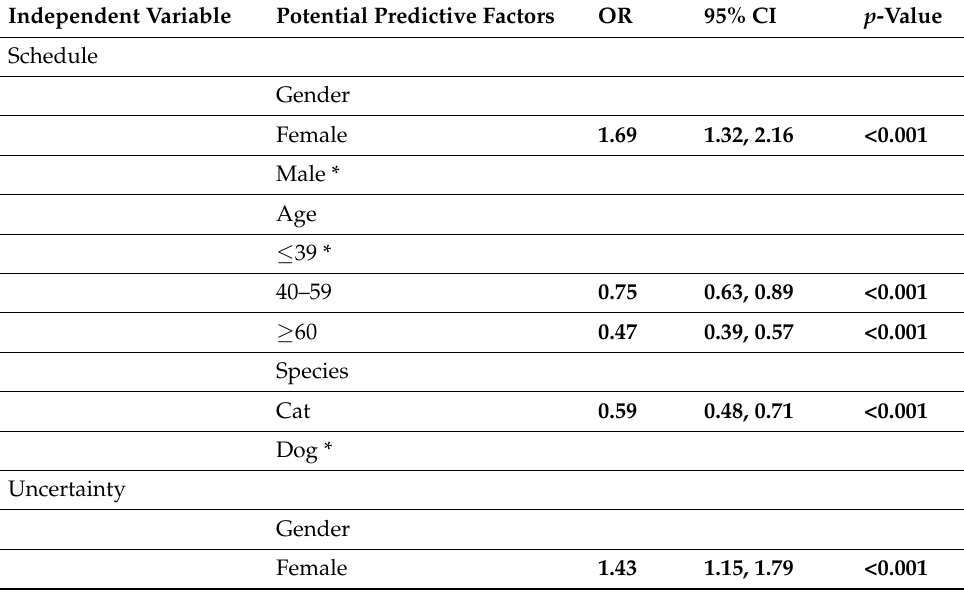
Table 7. Binary regression for negative COVID-19 related